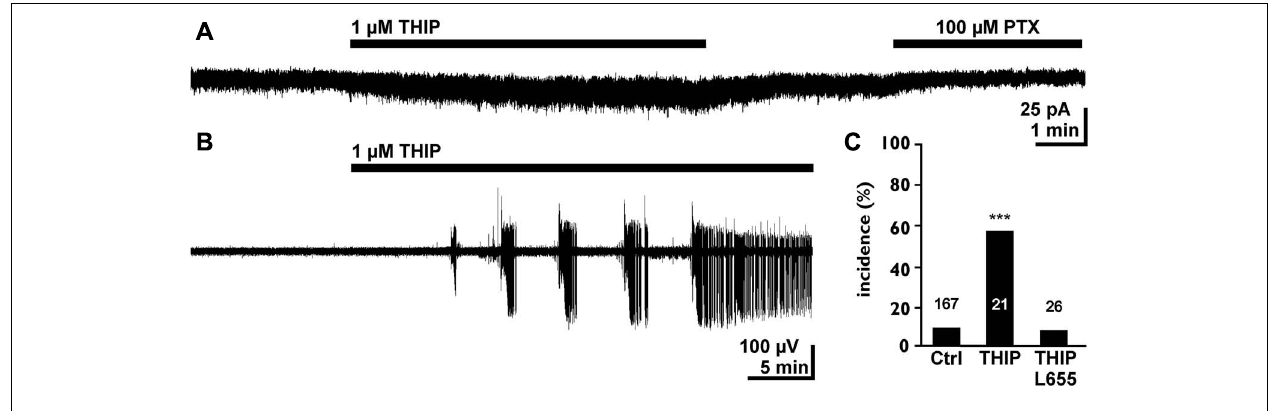
FIGURE 4 |Tonic GABAergic currents can promote epileptiform activity in the early postnatal hippocampus. (A) Whole cell recording of a CA3 pyramidal neuron in the P4–7 hippocampus.The experiment was performed in the continuous presence of 40 μ M dl-2-amino-5-phosphopentanoic acid (APV), 10 μ M 6-cyano-7-nitro-quinoxaline-2,3-dione (CNQX), and 1 μ M gabazine (GBZ) to block synaptic components. Note that bath application of 1 μ M 4,5,6,7-tetrahydroisooxazolo[5,4-c]pyridin-3-ol hydrochloride (THIP) induced a small tonic current and that the GABA A antagonist